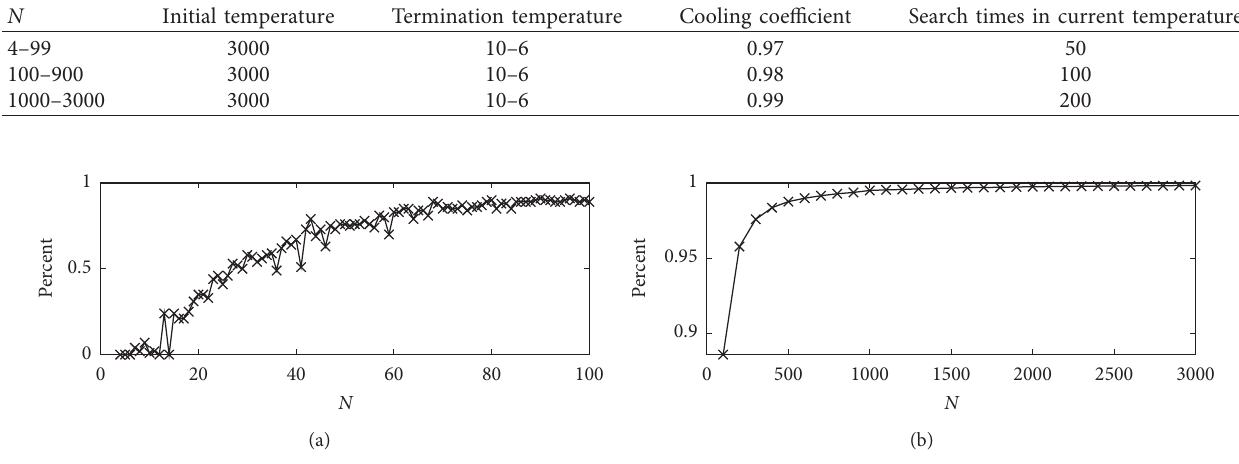
Figure 1: Time proportion of evaluation function in SA